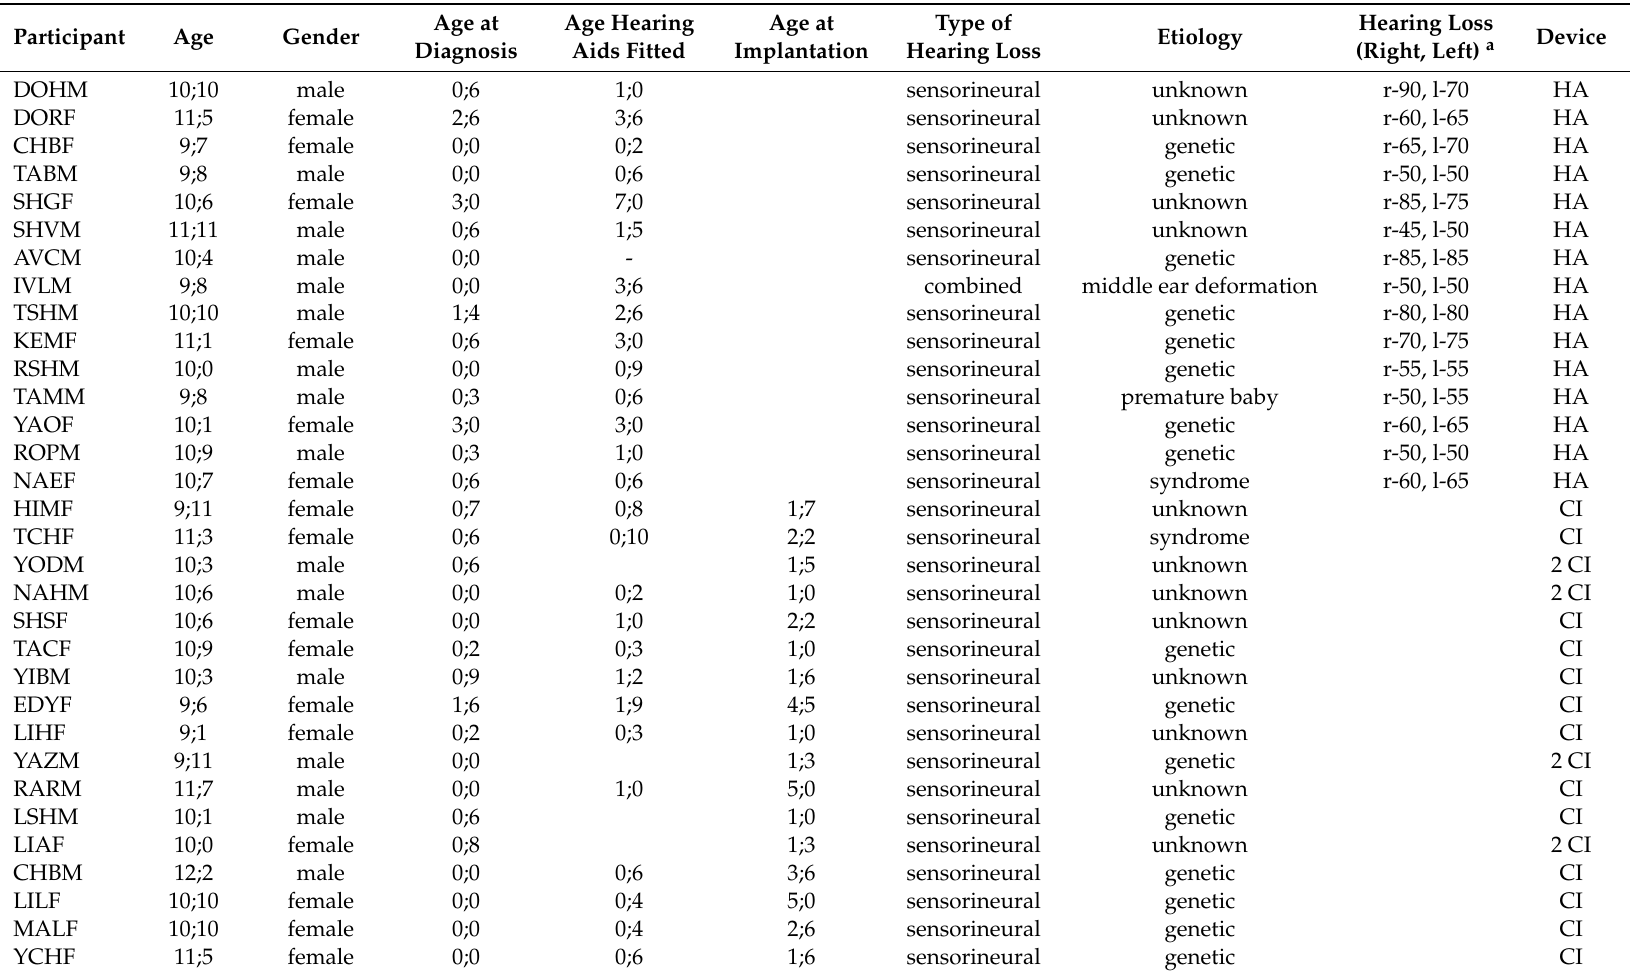
Table 1. Background information on the DHH